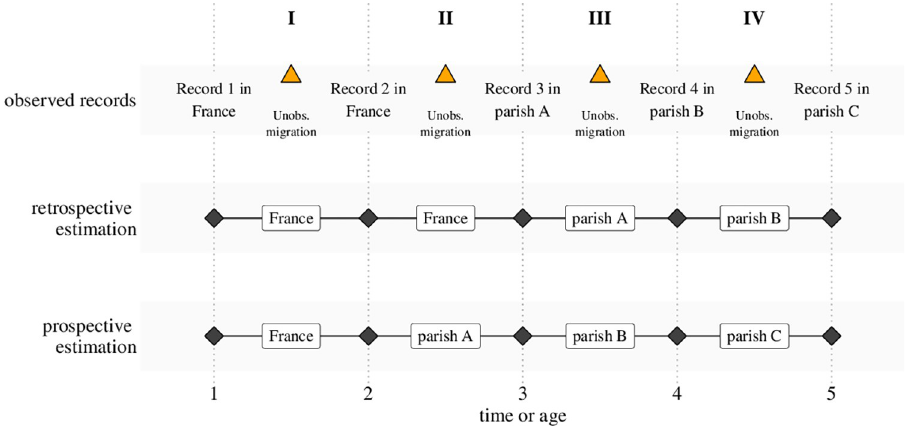
Fig 1. Different variants of sex ratio